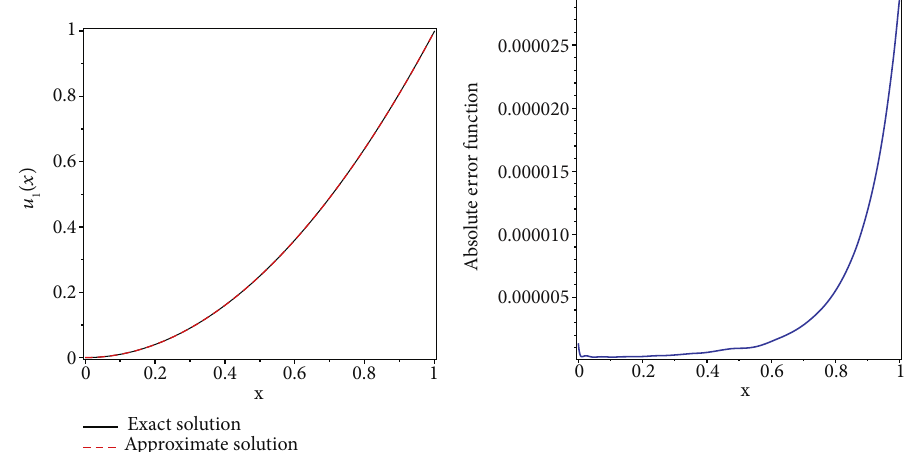
ð x Þ for N = 25 of Example 3. 1